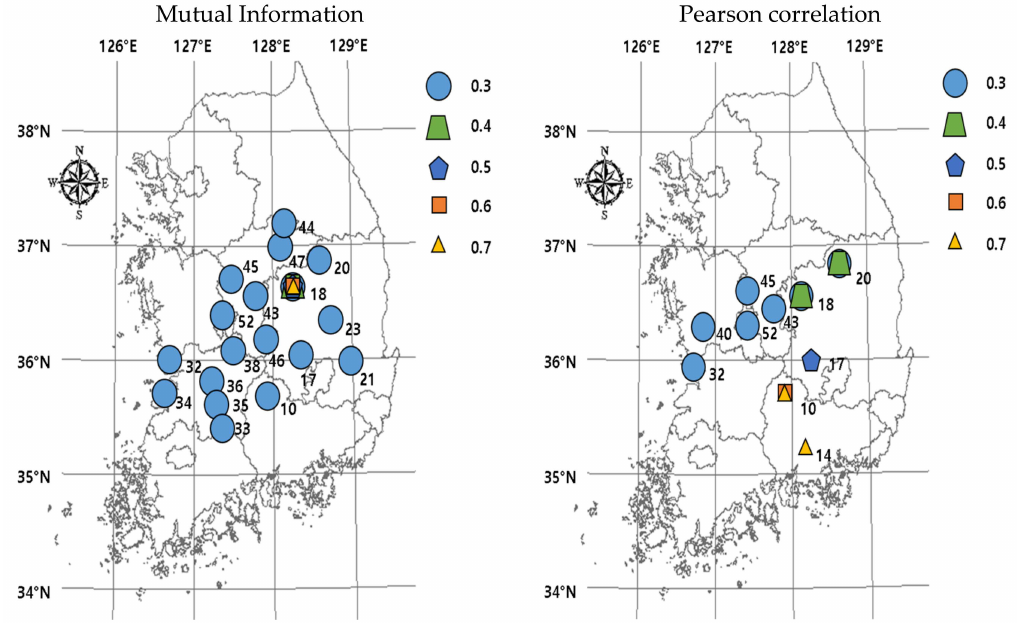
Figure 9. Locations of the most important station according to the threshold. The stations that have the highest value of centrality are expressed in the map according to the threshold (0.3, 0.4, 0.5, 0.6, 0.7). The location of the station in the case of mutual information is in the central of the Korean peninsula. The result of Pearson correlation shows that locations of the highest ranked station are moving into the south part of the Korean